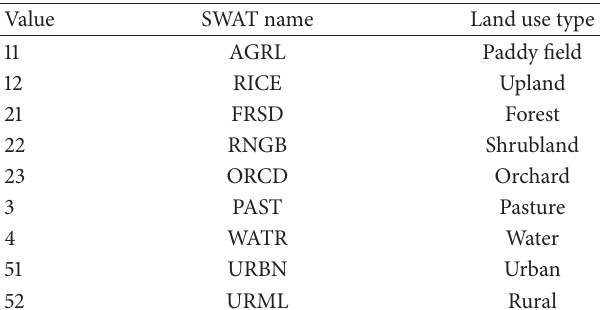
Table 1: Land use type value and